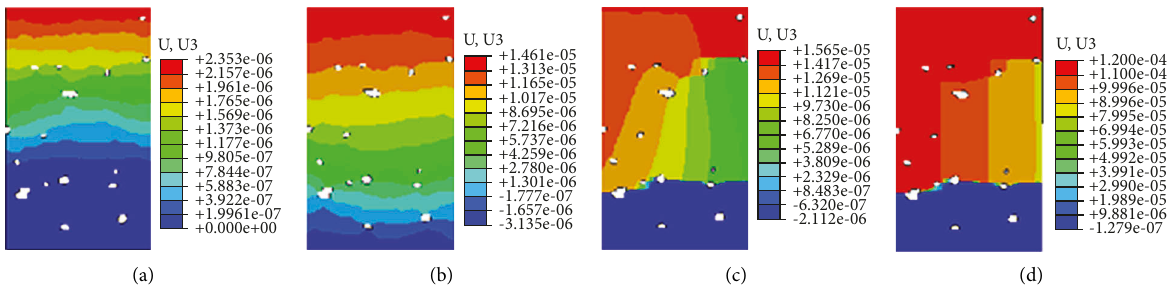
Figure 19: Vertical displacement graphs under different loading displacement. (a) s � 0.002mm. (b) s � 0.015mm. (c) s � 0.016mm. (d) s � 0.12mm.